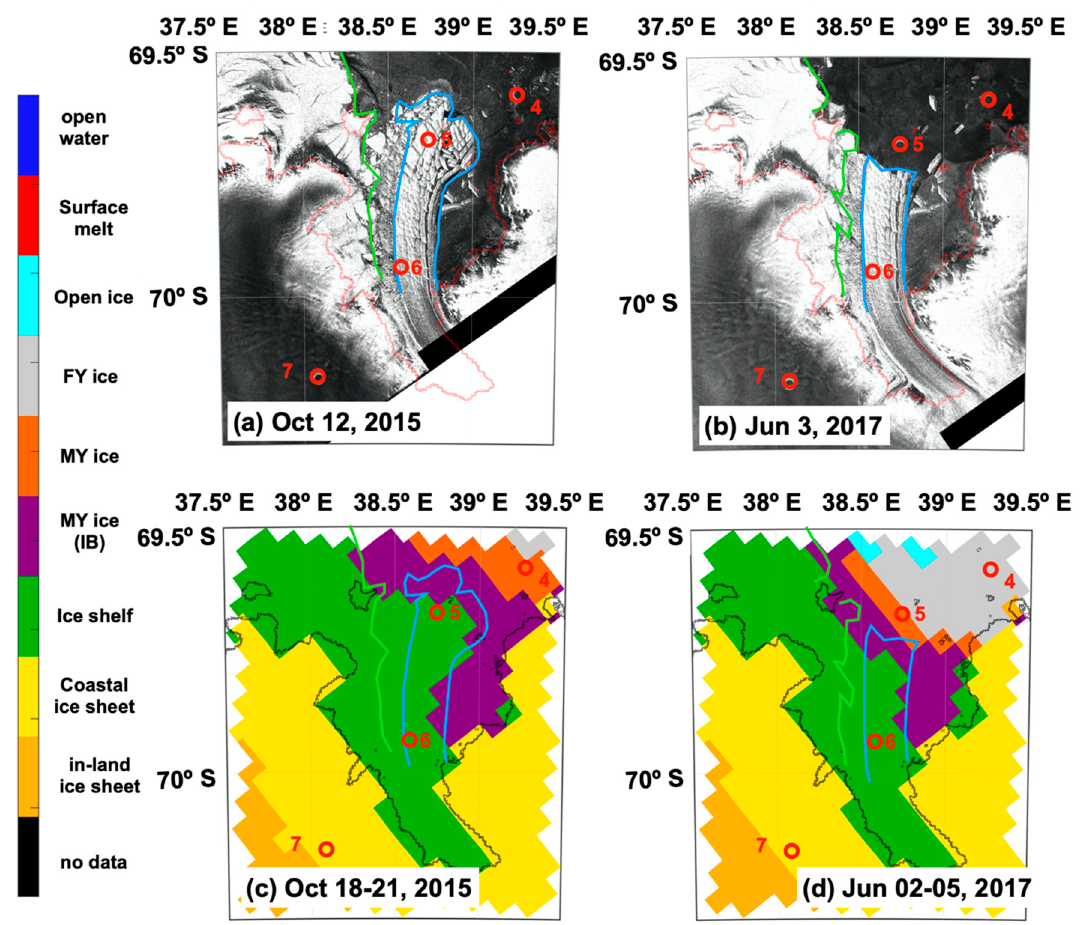
Figure 8. Enlarged view around the ice tongue of Shirase Glacier. ( a,c ) Classification results and C-SAR images before outflow in April 2017. ( b,d ) Classification results and C-SAR images after outflow in May 2017.